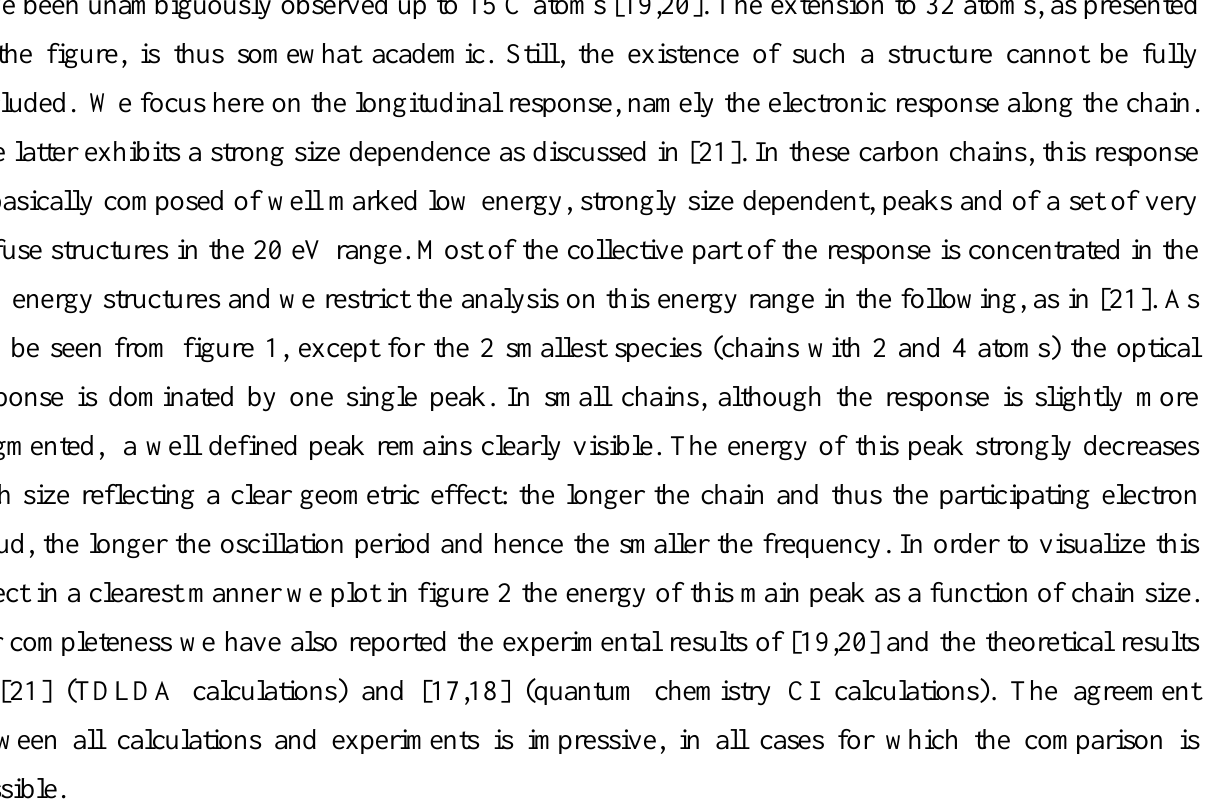
Figure 1. Longitudinal optical response of linear chains of carbon C response for energies beyond 15 eV does not exhibit significant peak structures, whatever the